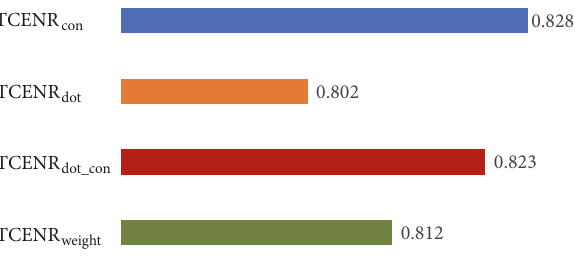
Figure 4: Comparison of merging methods in terms of accuracy. Table 2: Model’s accuracy with different layers.